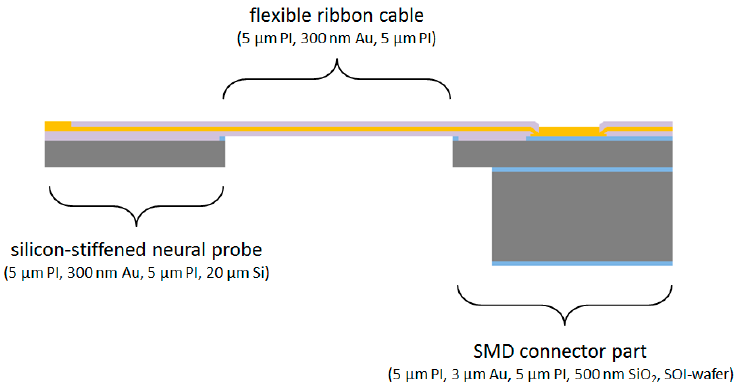
Figure 2. Cross section view of the general neural probe design with three monolithically integrated parts: silicon-stiffened neural probe, highly-flexible ribbon cable, and connector part for soldering of a SMD connector.